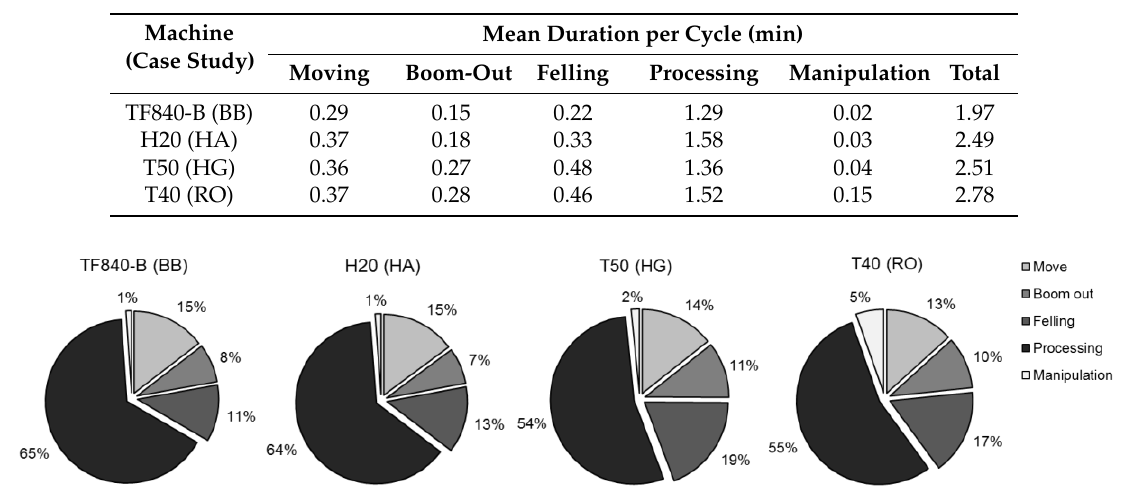
Table 5. Mean duration of work elements per cycle (i.e., tree) in the fully-mechanized (FM) group.